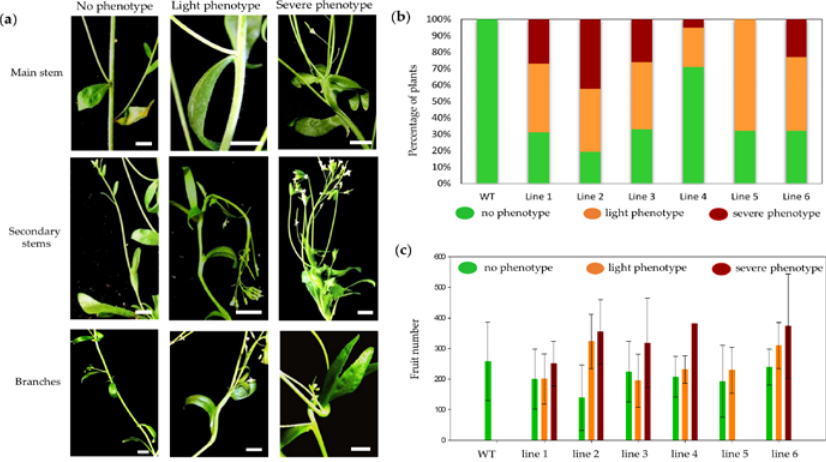
Figure 3. Classification of phenotypes observed in 164-OE Arabidopsis lines. ( a ) Phenotype classification and ( b ) Percentage of plants observed for each phenotype; ( c ) Quantification of fruits in 164-OE Arabidopsis lines (WT n = 15, line 1 n = 26, line 2 n = 21, line 3 n = 26, line 4 n = 21, line 5 n = 25, line 6 n = 22). n indicates the number of plants analyzed. For all cases, the means and LSD intervals at a confidence level of 95% were plotted. Scale bars = 1 cm.